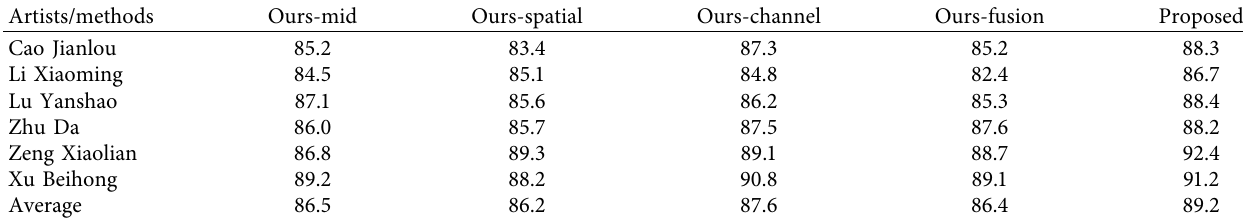
Table 4: Accuracy comparison of the ablation experiment on the Case-3 category of the